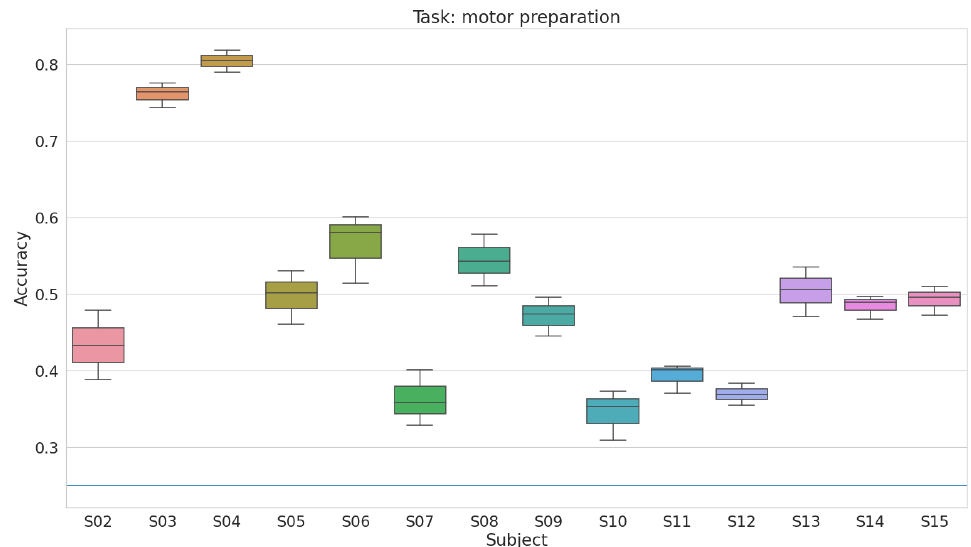
Figure 3. Test accuracy for each of the subjects. The accuracy is averaged over the considered epoch. The results are aggregated across folds. The blue line denotes the accuracy of a random